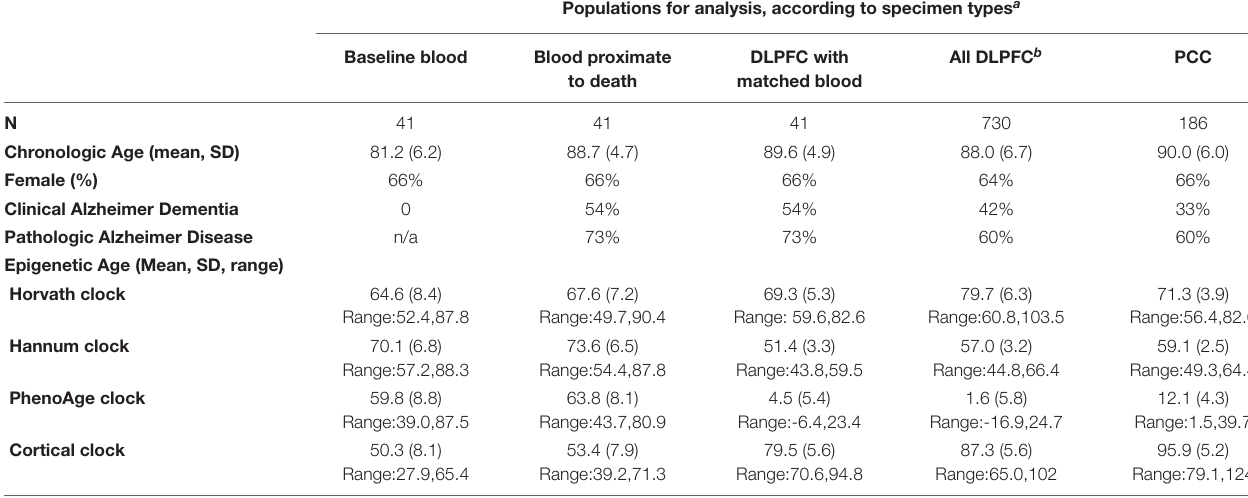
TABLE 1 | Characteristics of participants: Religious Orders Study and Memory and Aging